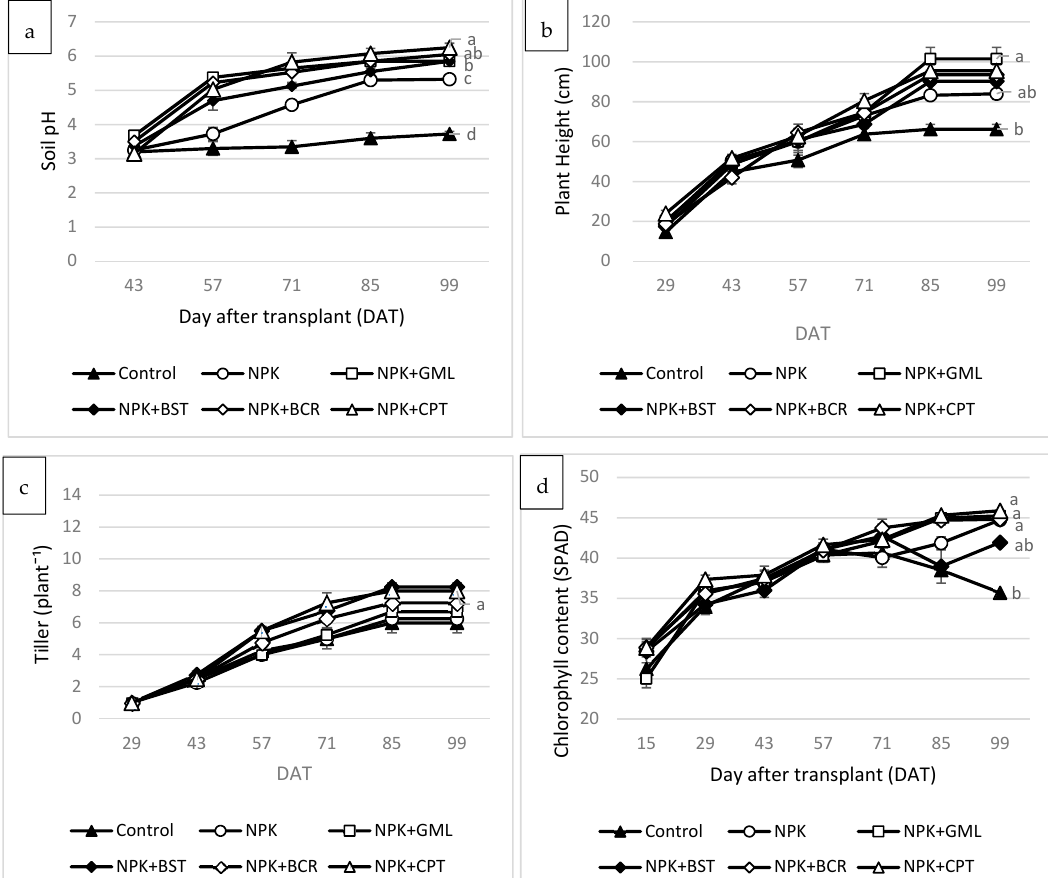
Figure 1. Effect of different amendments on ( a ) soil pH, ( b ) plant height, ( c ) tiller number, and ( d ) chlorophyll content during the entire cycle of rice growth. Vertical bars indicate the standard errors of the means ( n = 4). Different letters indicate a significant difference ( p < 0.05).